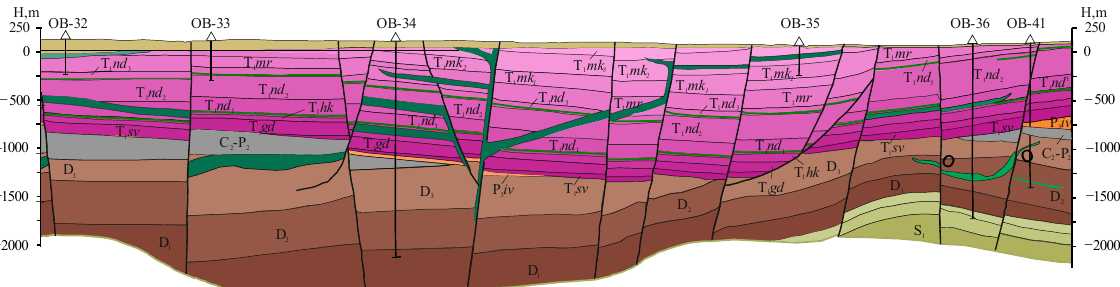
Figure 3. Cross-section the Vologochan syncline. Captions in Figure Figure 3. Cross ‐ section the Vologochan syncline. Captions in Figure 2. one includes tholeiitic basalts. Two thin (1.5 and 2 m) tuff horizons have been identified between the basalt flows. The total thickness of the formation is 160 m.